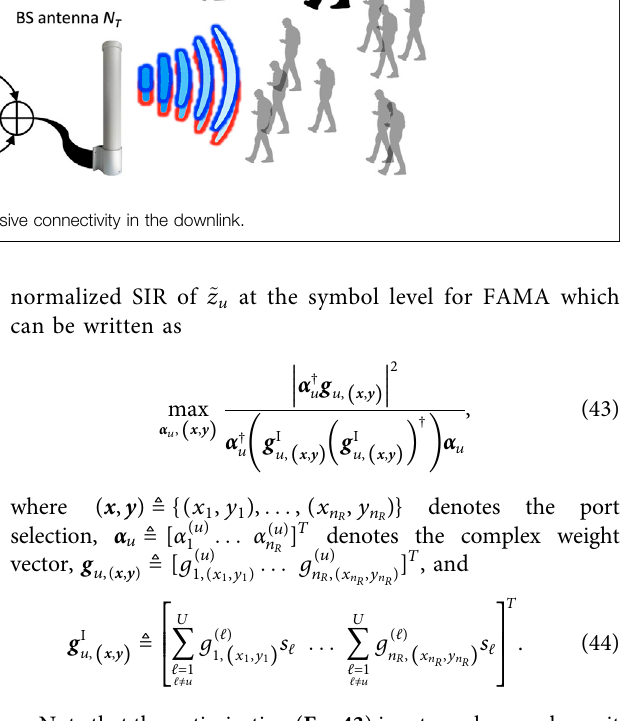
Frontiers in Communications and Networks |